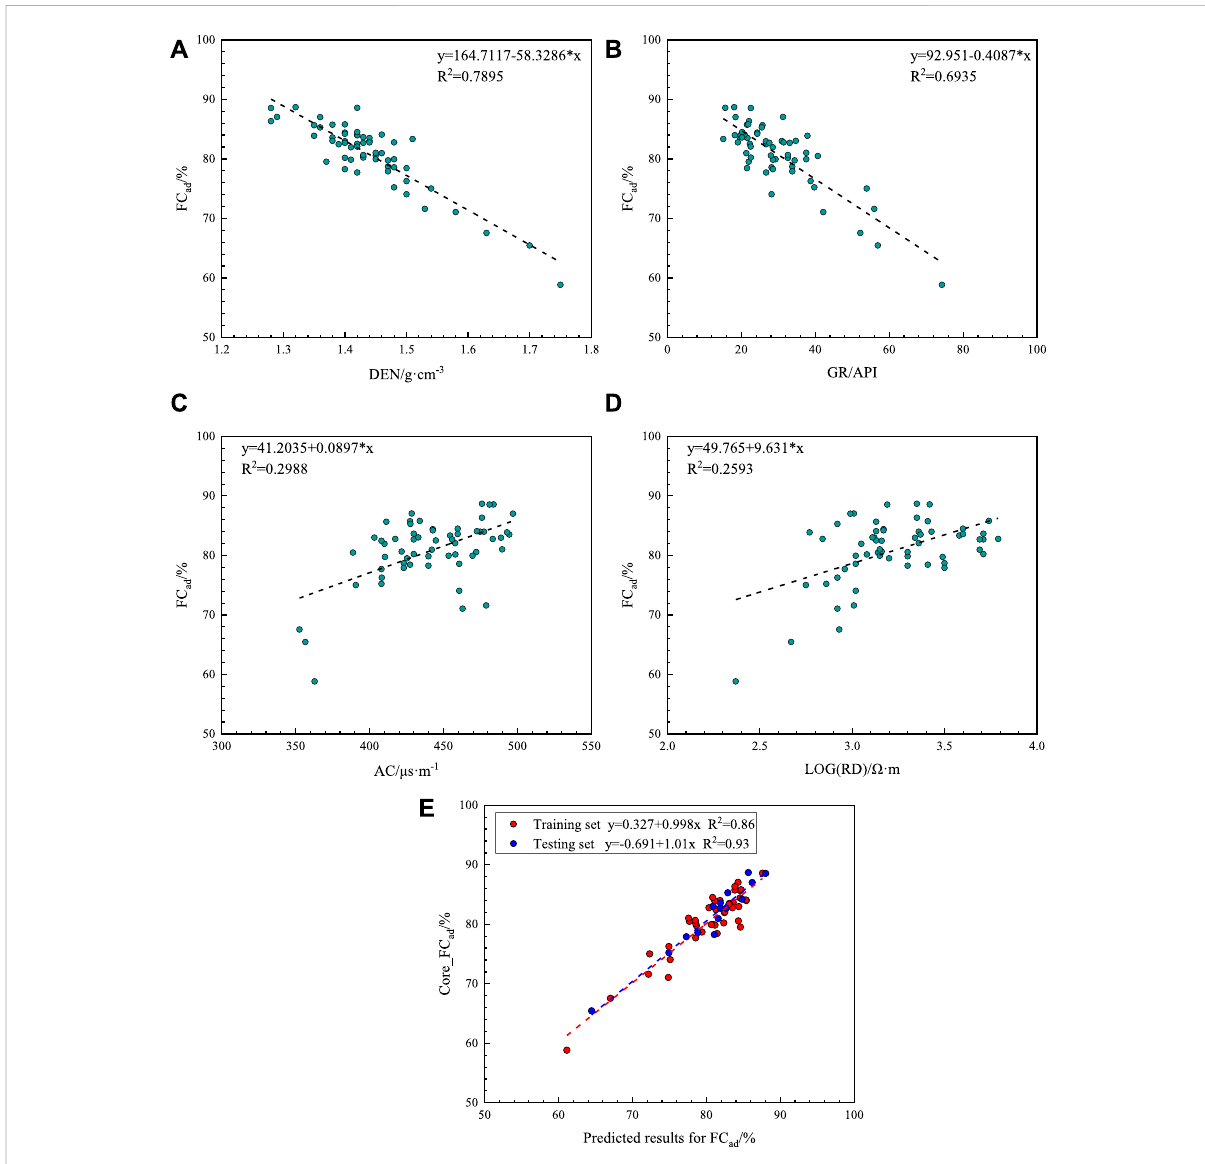
FIGURE 5 Correlation analysis of the FC ad content and the geophysical logging data response with the predicted results of the FC ad content. (A) Relationship betweenthe FC ad contentand DEN. (B) Relationship betweenthe FC ad contentand GR. (C) Relationship betweentheFC ad content and AC. (D) RelationshipbetweentheFC ad contentandRD. (E) PerformanceoftheOBGM(1,5)predictionmodelonthetrainingandtestsetsfortheFC ad